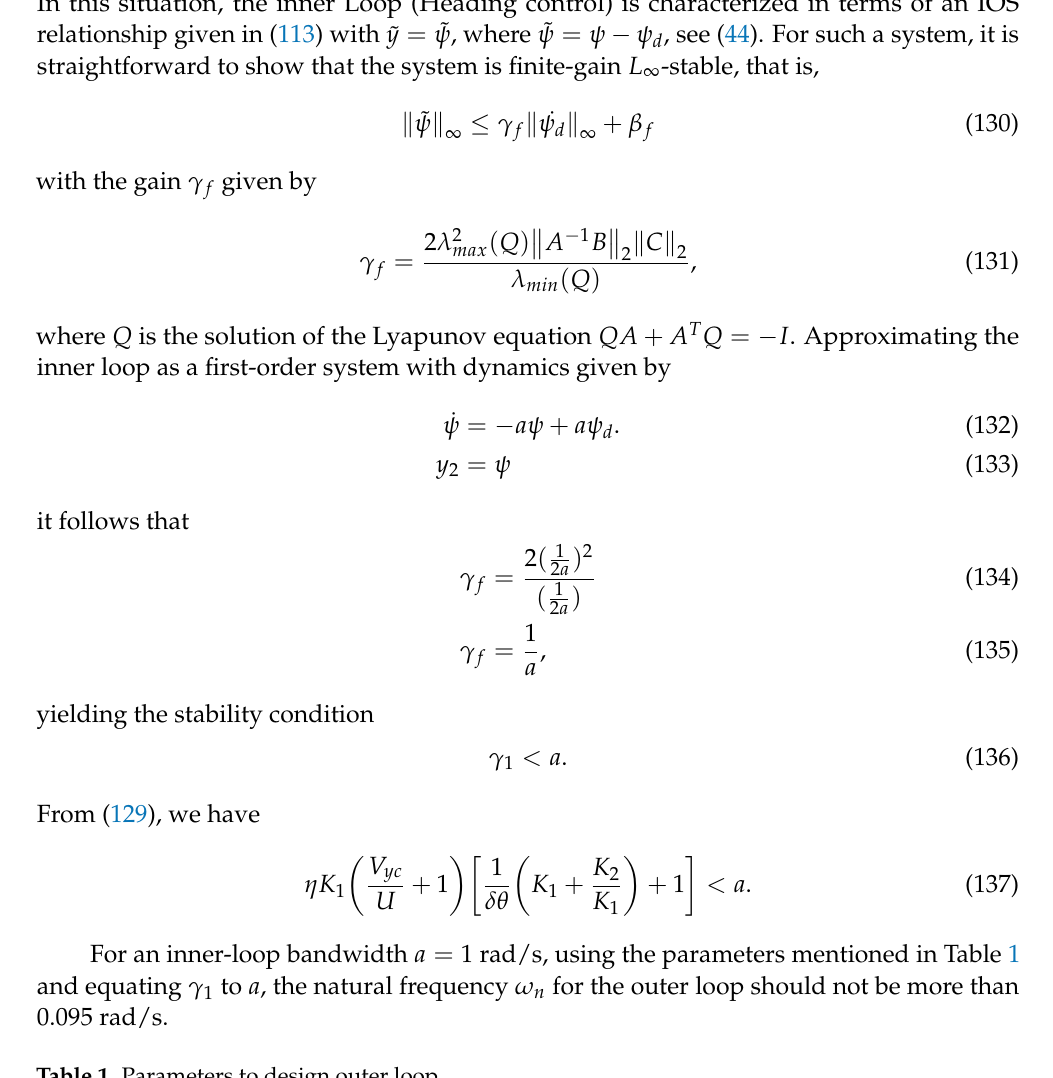
Table 1. Parameters to design outer